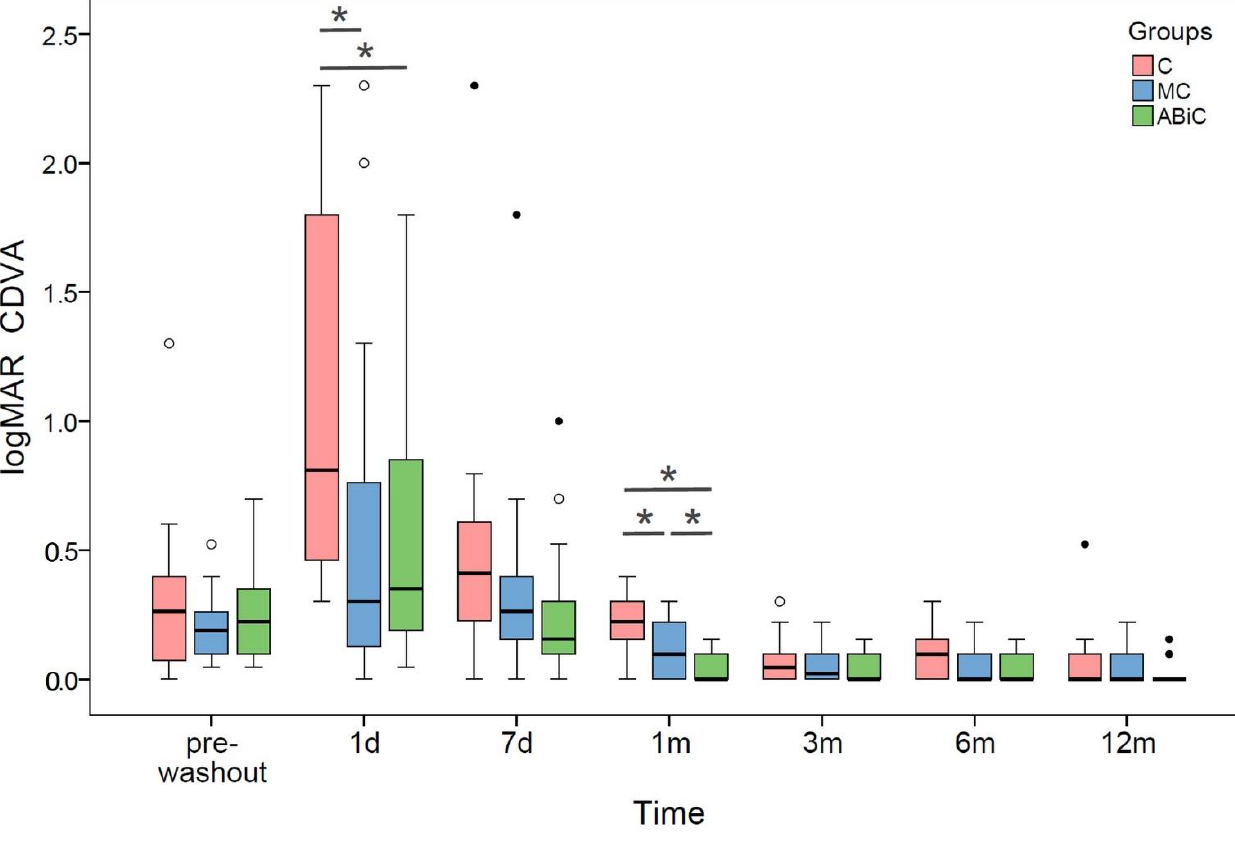
Figure 3. Boxplots of CDVA median values at each time stage before and after surgery in three groups of patients: ab externo canaloplasty (ABeC), minicanaloplasty (miniABeC) and ab interno canaloplasty (ABiC). Asterisks denote statistically significant differences between particular groups ( p < 0.05).